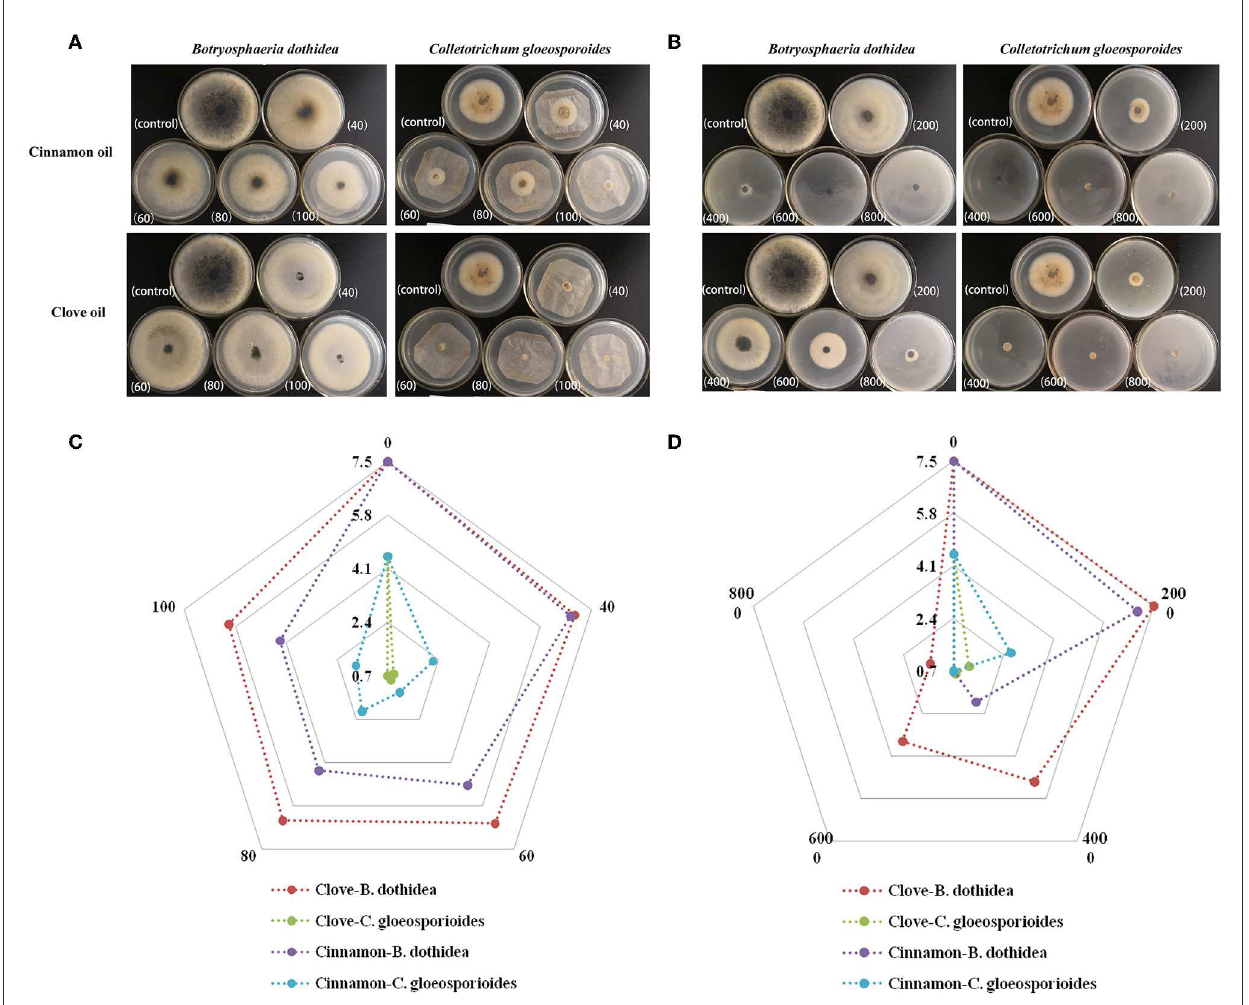
FIGURE3 Mycelial growth inhibition of cinnamon and clove EOs against B. dothidea and C. gloeosporioides . (A) Morphological images of medium in EO vapor phase. (B) Morphological images of medium in EO contact phase. (C) Radar map of the radical growth diameters in EO vapor phase. (D) Radar map of the radical growth diameters in EO contact